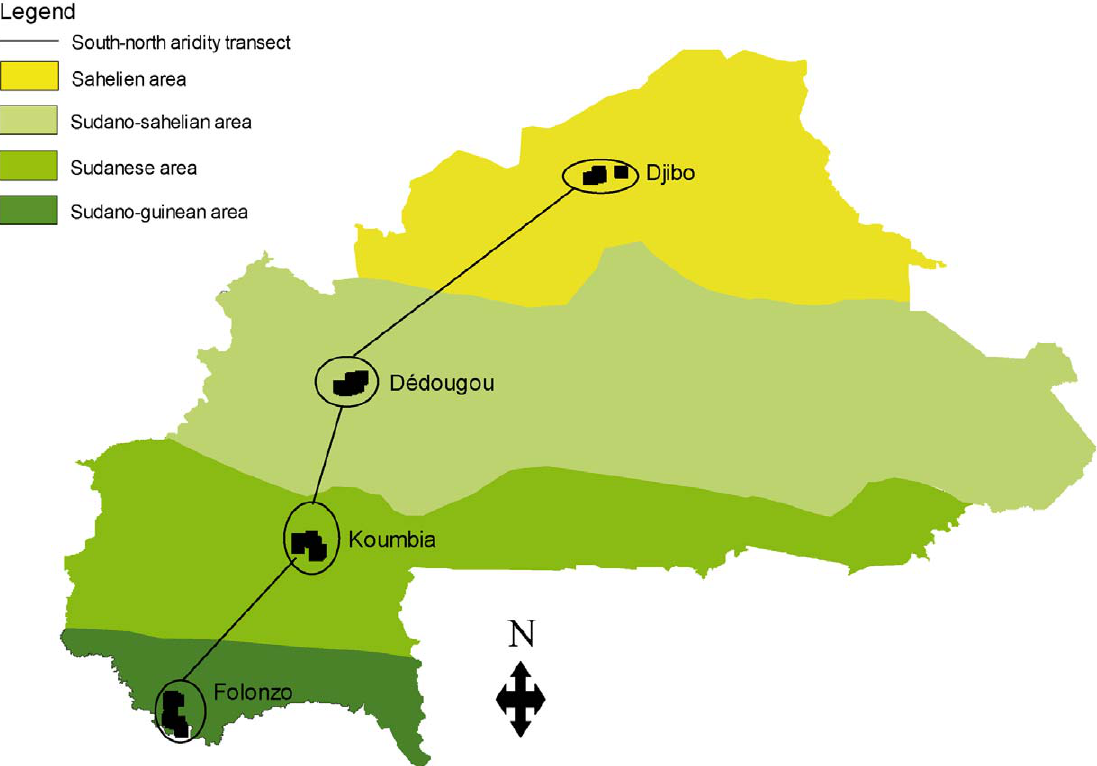
Figure 1. Location of the study sites along the climatic gradient in Burkina Faso.